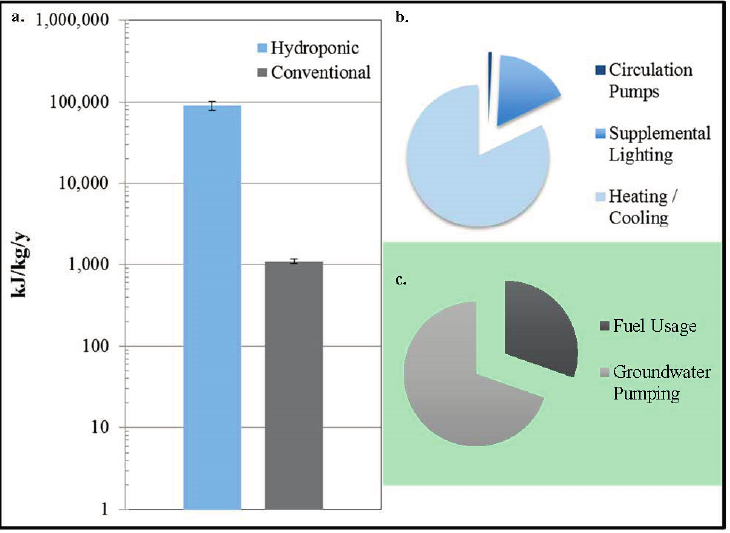
Figure 3. ( a ) Modeled annual energy use in kilojoules per kilogram of lettuce grown in southwestern Arizona using hydroponic vs. conventional methods; ( b ) The energy use breakdown related to the hydroponic production of lettuce; ( c ) The energy use breakdown related to the conventional production of lettuce (Error bars indicate one standard